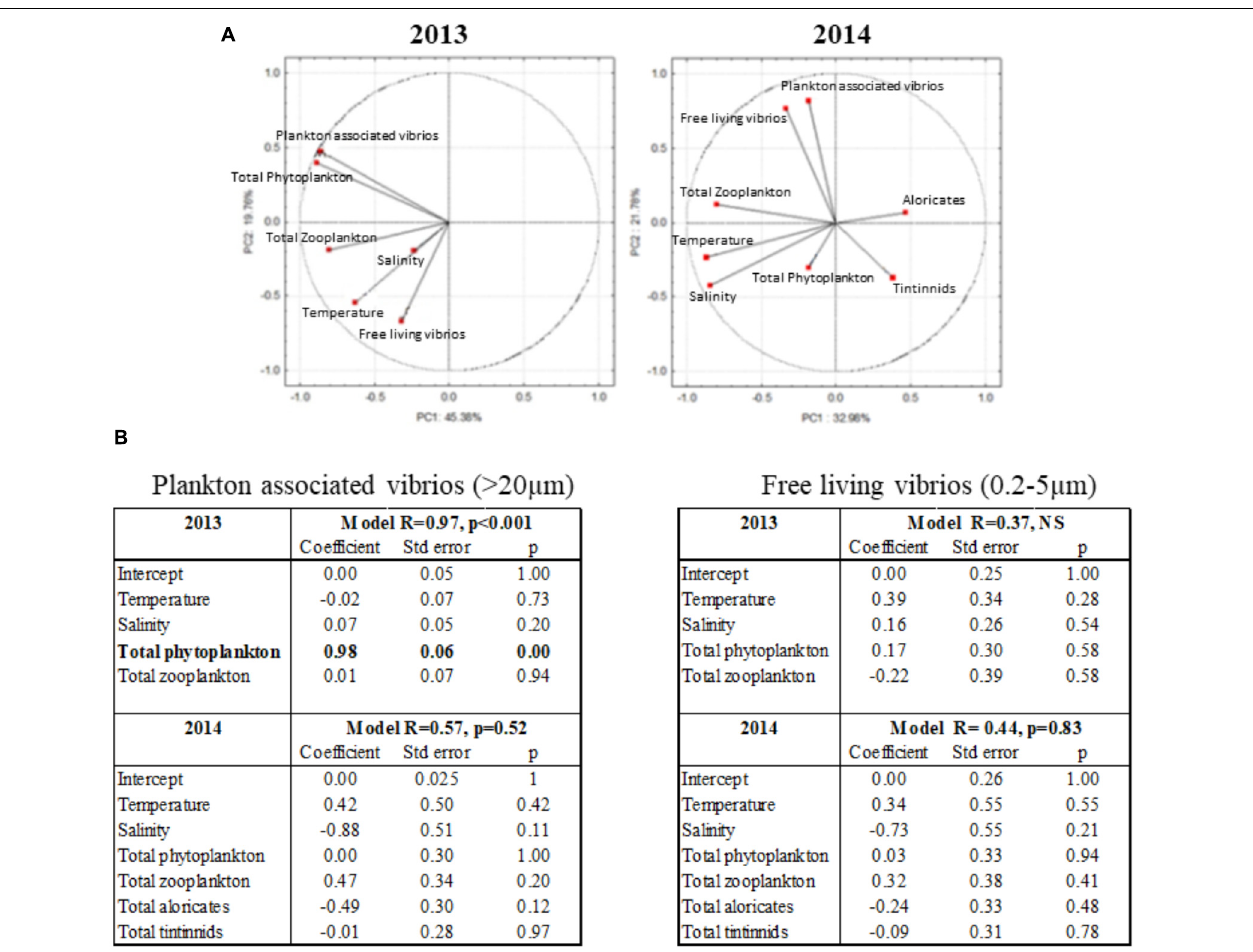
FIGURE 5 | Relationships between total vibrios abundance and environmental parameters. (A) Principal component analysis of environmental data from 2013 to 2014: Temperature, Salinity, Total Zooplankton, Total Phytoplankton, Plankton-associated vibrios ( > 20 µ m fraction), Free-living vibrios (0.2–5 µ m fraction). For 2014, ciliates data (microzooplankton) are also presented divided into two types of organisms: Aloricates and Tintinnids. (B) Results of a general linear model showing the relative importance of environmental variables on the plankton associated vibrios abundance (16S rRNA in the > 20 µ m fraction) and the free-living vibrios (0.2–5 µ m fraction). Results in boldface indicate a significant ( p < 0.05) effect of the